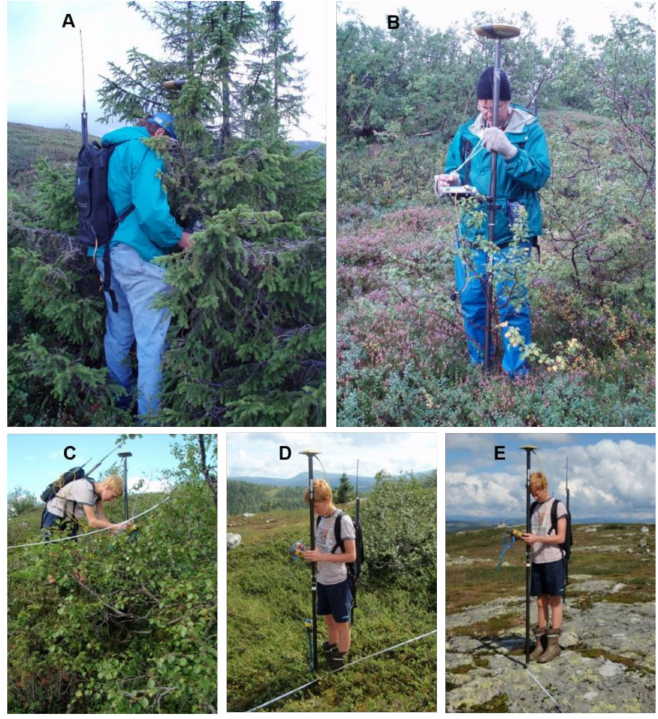
Figure 2. Tree measurements during field work in 2006 ( A , B ) and measurements of ground reference points in 2010 ( C , D , E ). ( A ) Spruce tree appearing in a group of trees. ( B ) Birch tree part of a group of trees forming tall scrubby vegetation. ( C ) Ground reference point with vegetation height > 0.20 m and “green vegetation”. ( D ) Ground reference point with vegetation height 0.10–0.20 m and “green vegetation”. ( E ) Ground reference point with vegetation height < 0.10 m and “rock/bare”